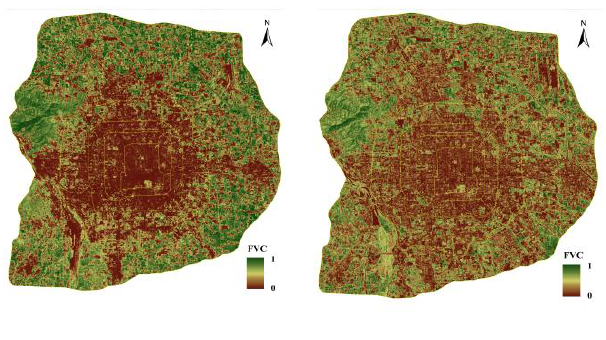
Spatial distribution of FVC, WD, ISC, NPP, LST inside of Beijing 6 th Ring Road of 2002 and 2013 was shown in Figure 3, and the change data of the ecological environment indicators are shown in Table 2.